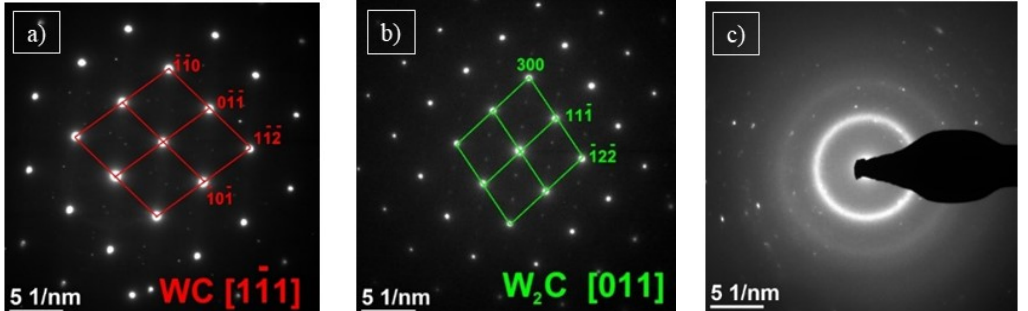
9 of 16 types (Figure 8). The particles marked with red arrows and named with the letter A (Fig- ure 8a) are larger (1–2 µm) than others and irregular shapes. The analysis of the chemical composition (Figure 8b) confirmed the presence of tungsten (100 at. %). Figure 8. STEM micrograph in BF of sample C1 ( a ); the results of chemical analysis marked with letter A ( b ).